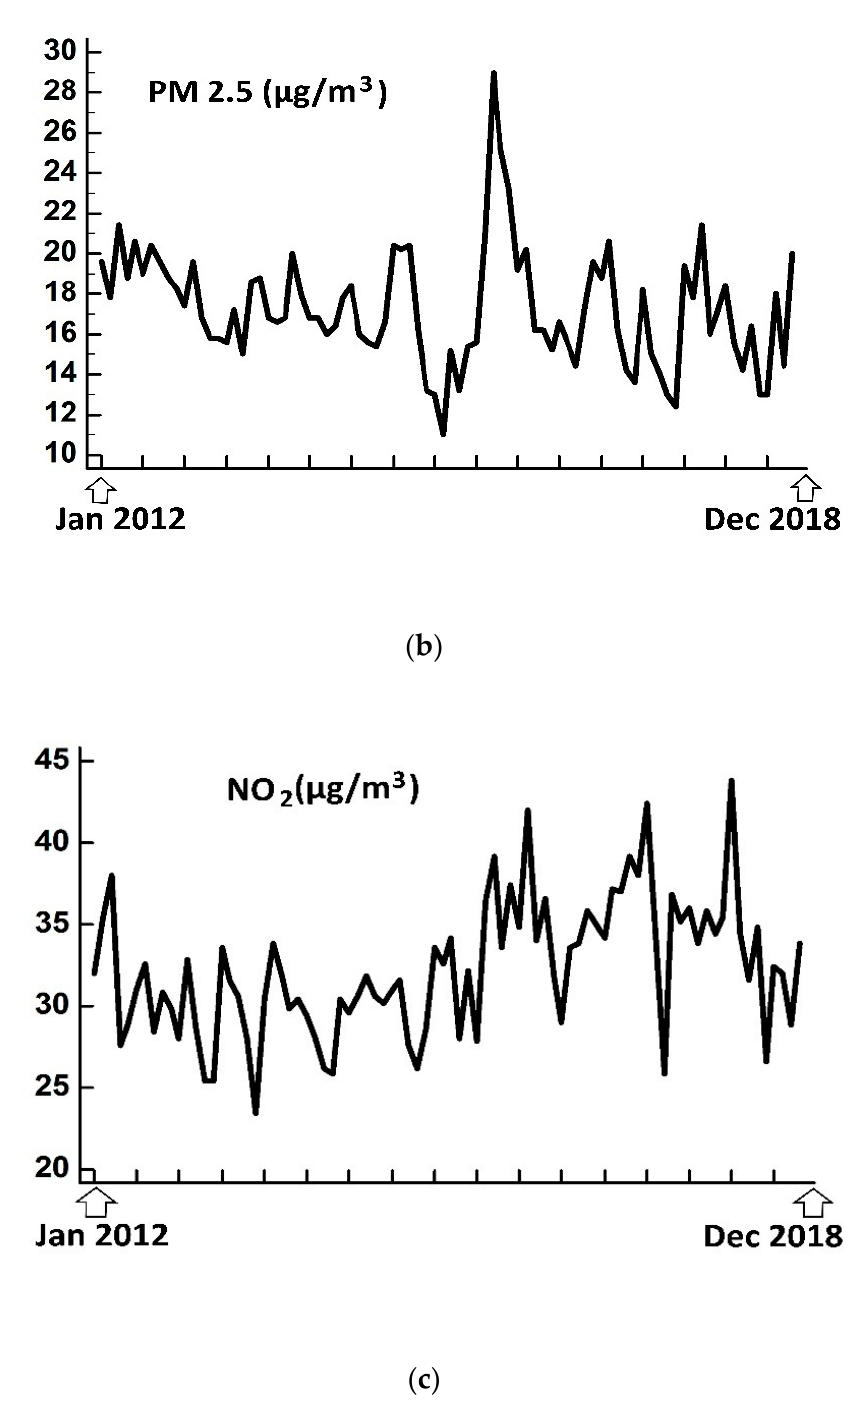
Figure 2. Average monthly air pollutants’ levels PM10 ( a ), PM2.5 ( b ) and NO 2 ( c ) from the five monitoring stations) during the study period (January 2012 to December 2018).